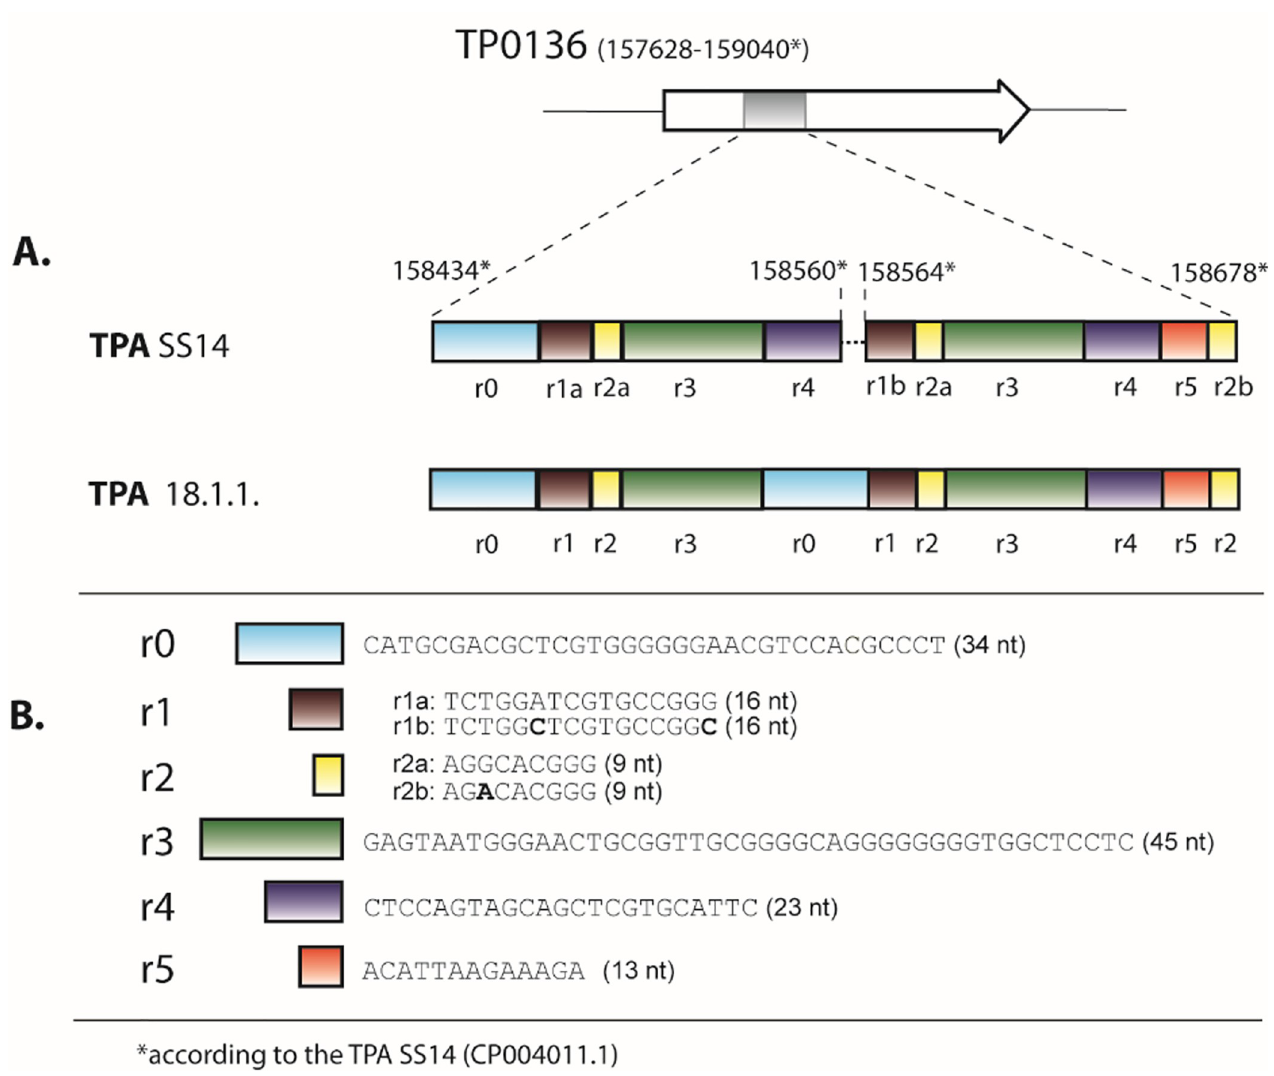
Fig 6. Modular structure of the TP0136 gene in the TPA SS14 strain and in the TPA 18.1.1. clinical isolate. A. A schematic representation of the TP0136 gene in the TPA SS14 strain between coordinates 158434–158678 (CP004011.1). The figure was modified from Strouhal et al . (2018) [45]. The r0 repetitive sequence in the TPA 18.1.1. clinical isolate replaced the first r4 repetitive sequence. B. A list of repetitive (r0, r1, r2, r3, r4, r6) and non-repetitive sequences (r5). The nucleotide differences within r1 and r2 repetitions in the TPA SS14 strain are shown in